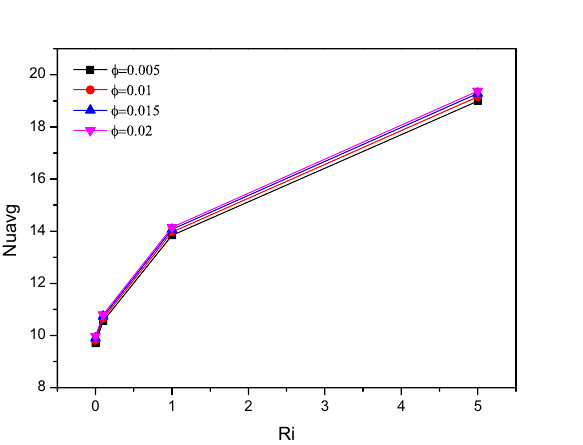
Figure 10. Variations of Nu avg with various Ri for solid volume fraction variations ( ϕ ), Re = 1000 , Ri = 1